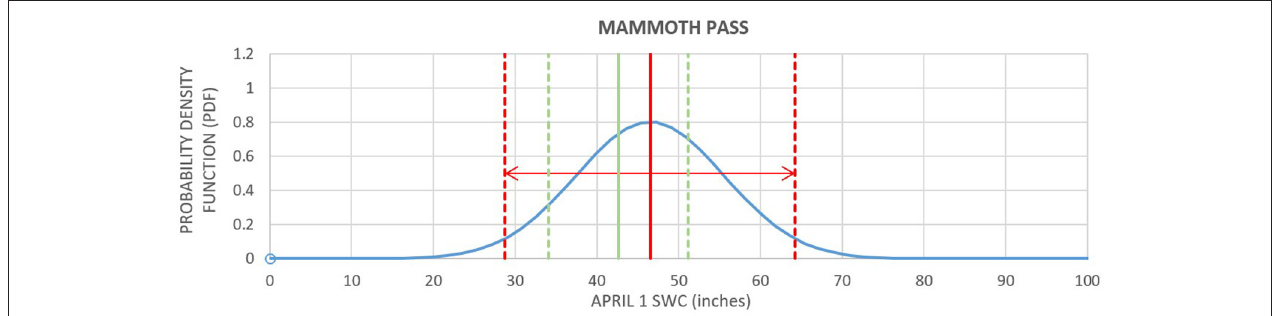
FIGURE 2 | Mammoth Pass April 1 SWC forecasts for year 2010 (red line). The red dashed lines indicate the 95% confidence interval, assuming the errors are normally distributed about the forecast value. The blue line is the Gaussian probability density function (PDF), with mean equal to the forecast value and standard error estimated from the 1951–2016 forecasts. The green line is the normal value (the average for 1966–2015), and the dashed green lines indicate the category boundaries defined by a 20% deviation from the normal